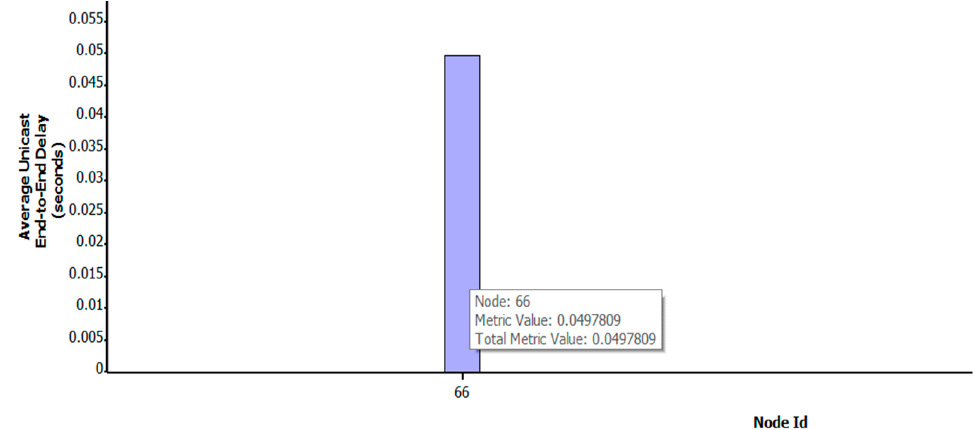
Figure 6. Average end–to–end delay under two–satellite–key–node attack scenario.